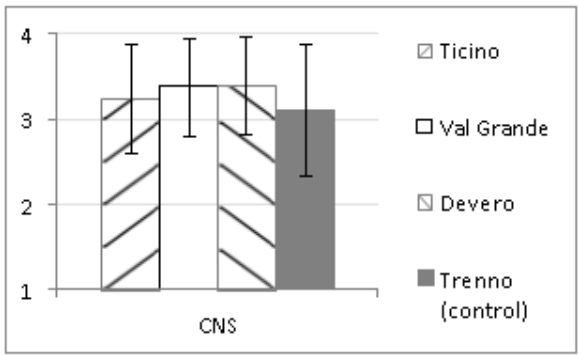
Figure 3. Mean scores for the perceived restorativeness scale (PRS), familiarity (FAM) and preference (PREF) (upper graph) and for the connectedness to Nature Scale (CNS) (lower graph) for each setting. A significant effect emerged for all the variables which differentiated significantly across settings following roughly this decreasing order: Devero, ValGrande, Ticino/Trenno.